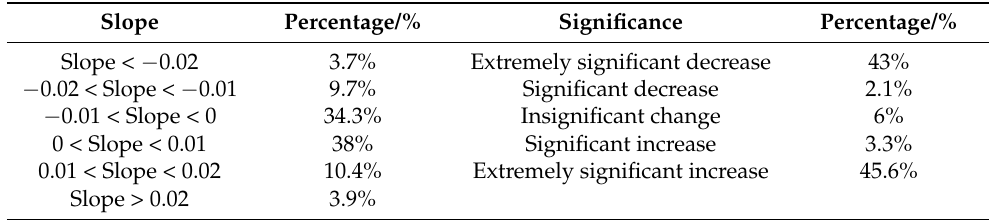
Table 2. Vegetation cover change and significance